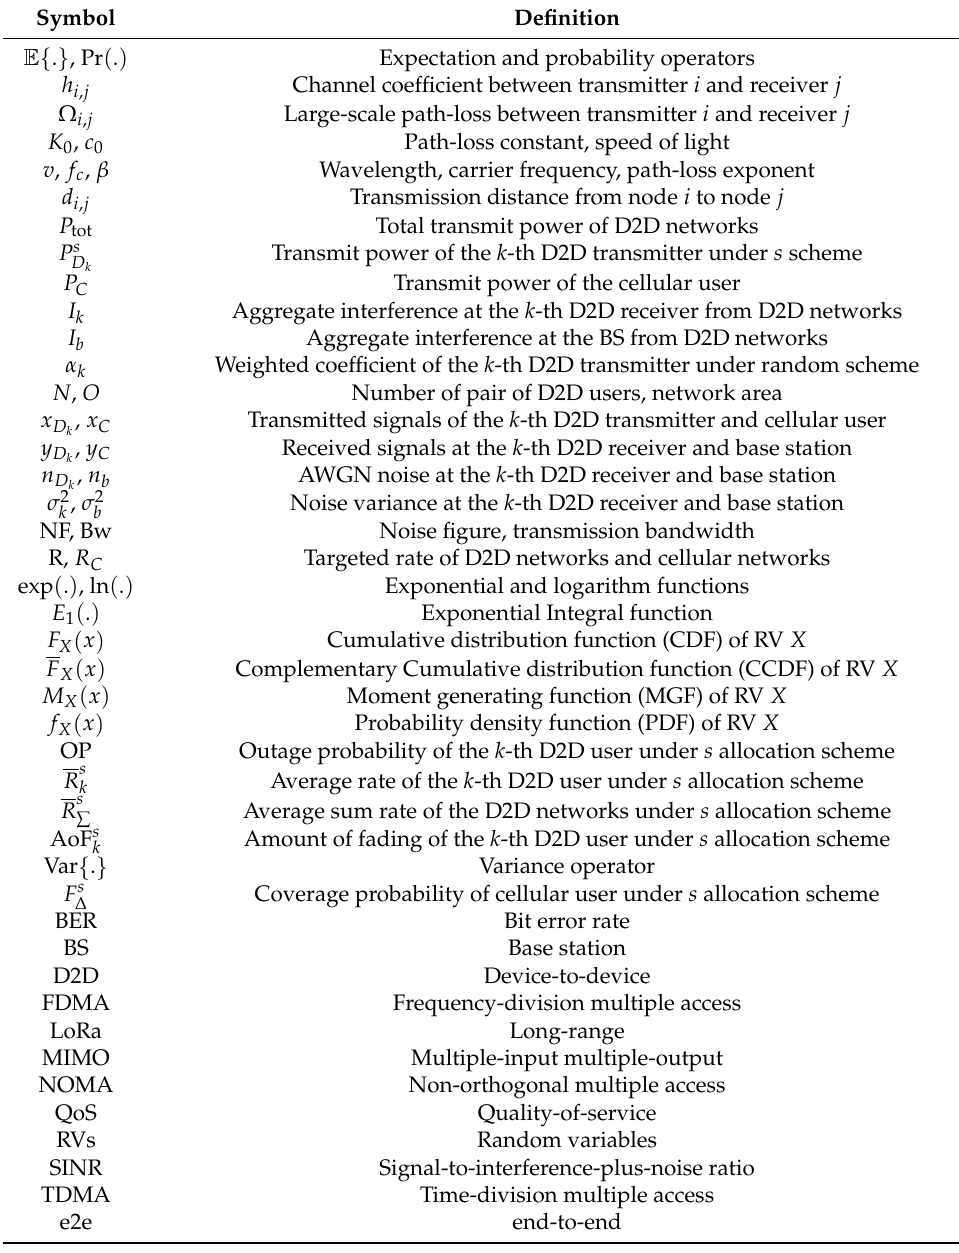
Table 1. Main notations and mathematical